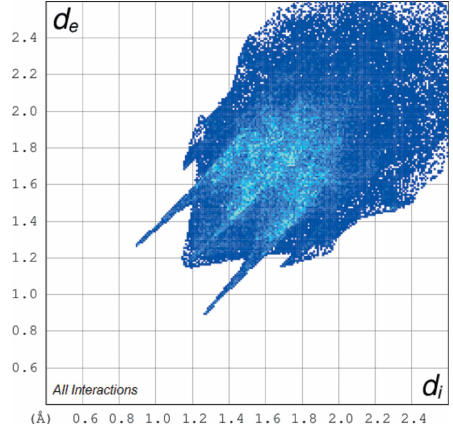
Figure 3 The two-dimensional fingerprint plot for the title compound depicting the overall contribution by the various contacts.